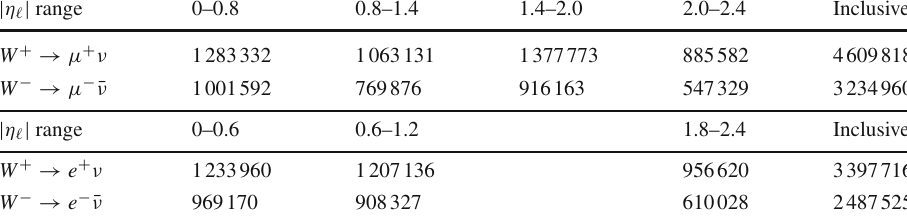
Table 9 Numbers of selected W + and W − events in the different decay channels in data, inclusively and for the various | η (cid:7) |